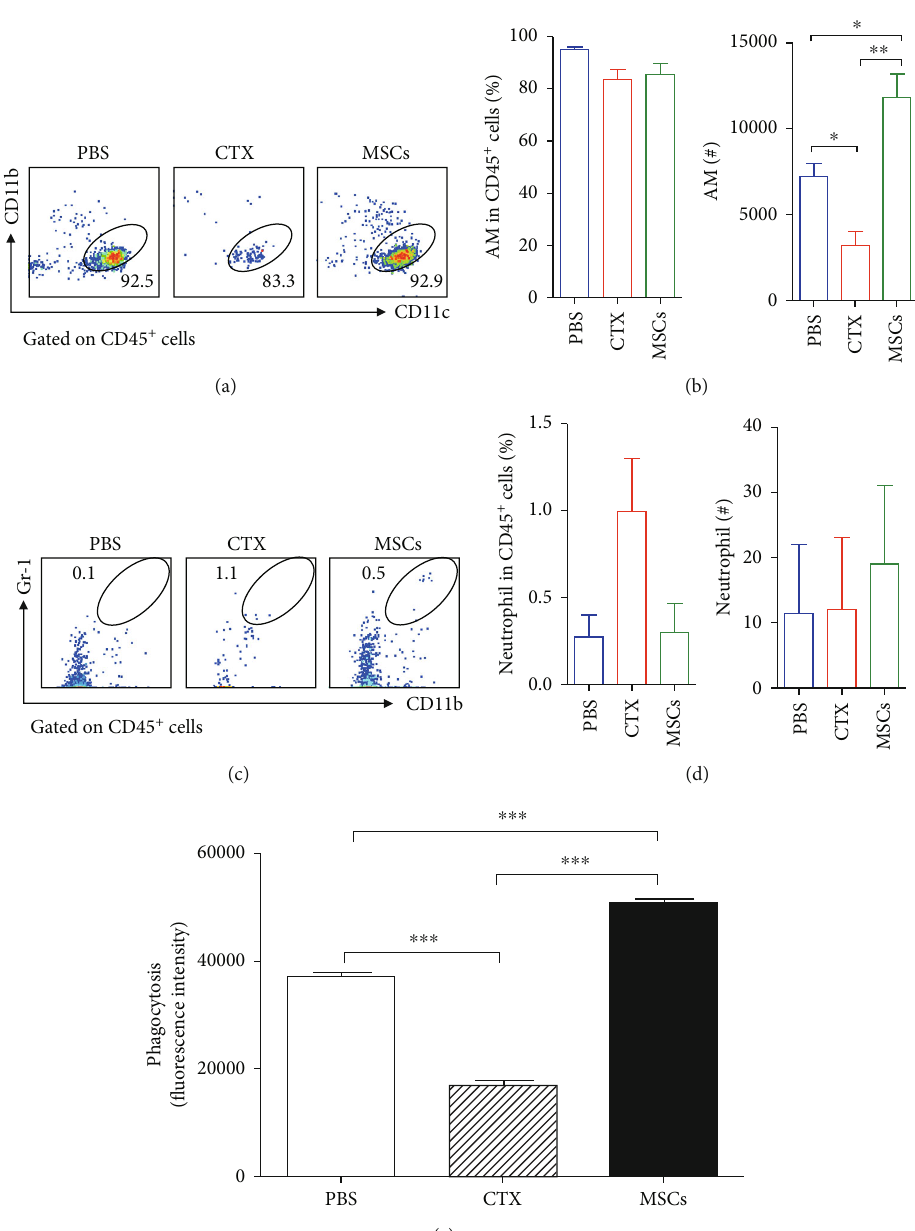
Figure 2: The number and phagocytic ability of alveolar macrophages were increased in the MSC-treated mice. Mice were treated with MSCs or CTX as described above. Cells in the BALF were collected and analysed by surface staining. The frequencies and absolute numbers of alveolar macrophages (CD11b - CD11c + ) (a, b) and neutrophils (CD11b + Gr-1 + ) (c, d) were determined by surface staining. (e) The phagocytic ability of AMs was determined. Data were expressed as the means ± SEM . n = 3 mice for each treatment group. ∗ p < 0 : 05 ; ∗∗ p < 0 : 01 . This experiment is representative of three individual